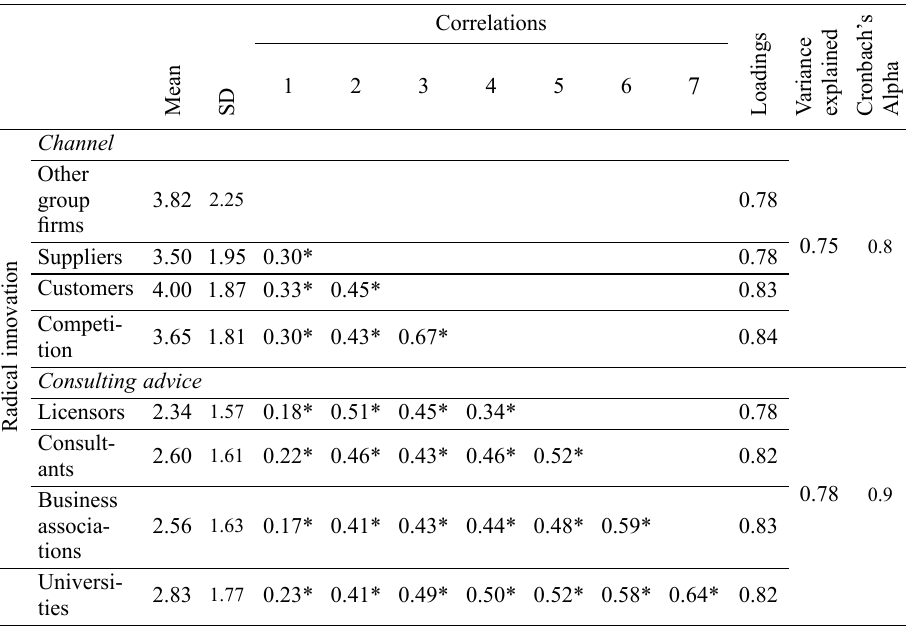
Table 5. Measurement scale: collaboration for radical innovation